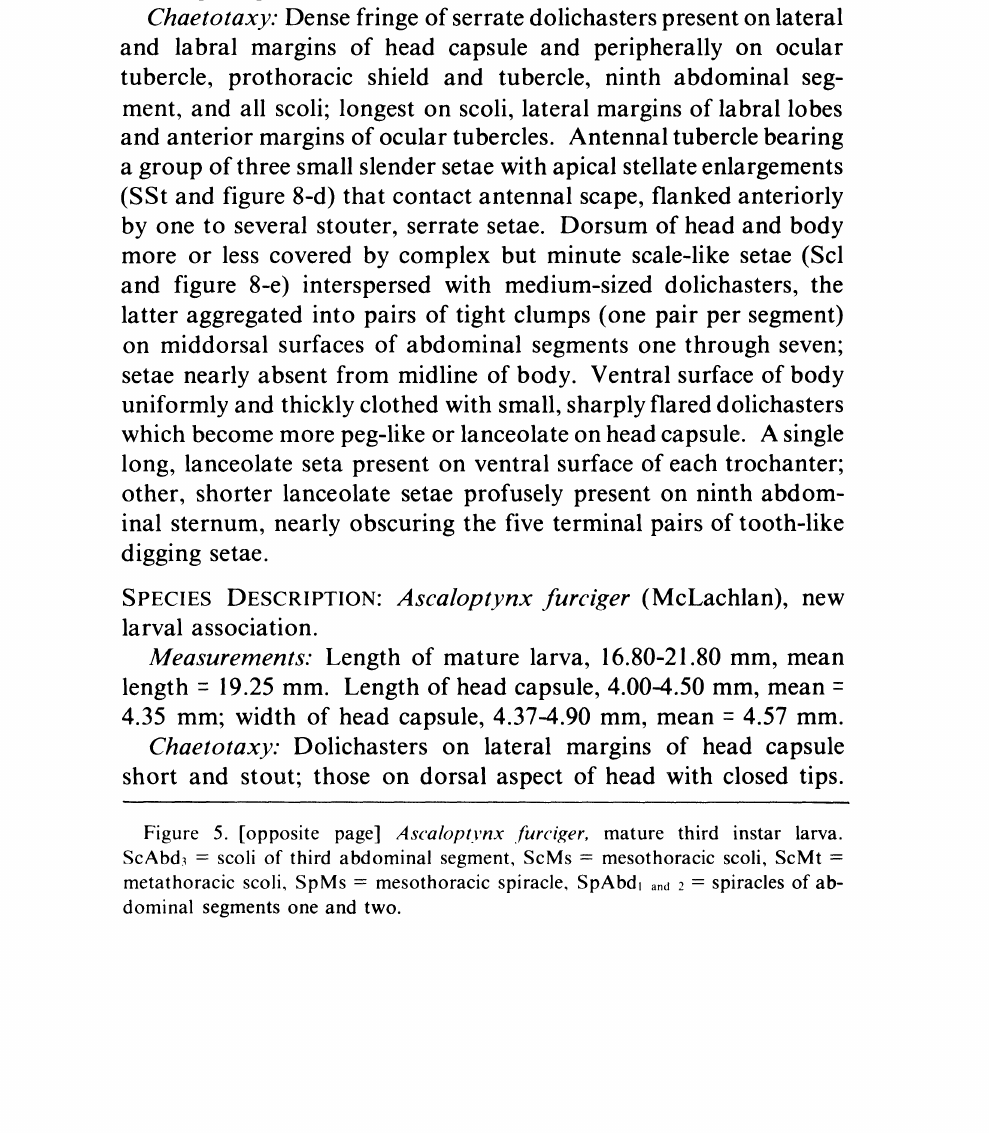
Figure 5. [opposite page] Ascaloptynx .furciger, mature third instar larva. ScAbd3 scoli of third abdominal segment, ScMs mesothoracic scoli, ScMt metathoracic scoli, SpMs mesothoracic spiracle, SpAbd spiracles of ab- dominal segments one and